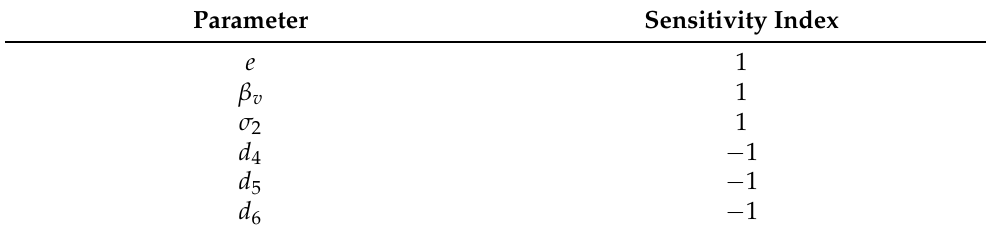
Table 3. Sensitivity indices of R 0 v